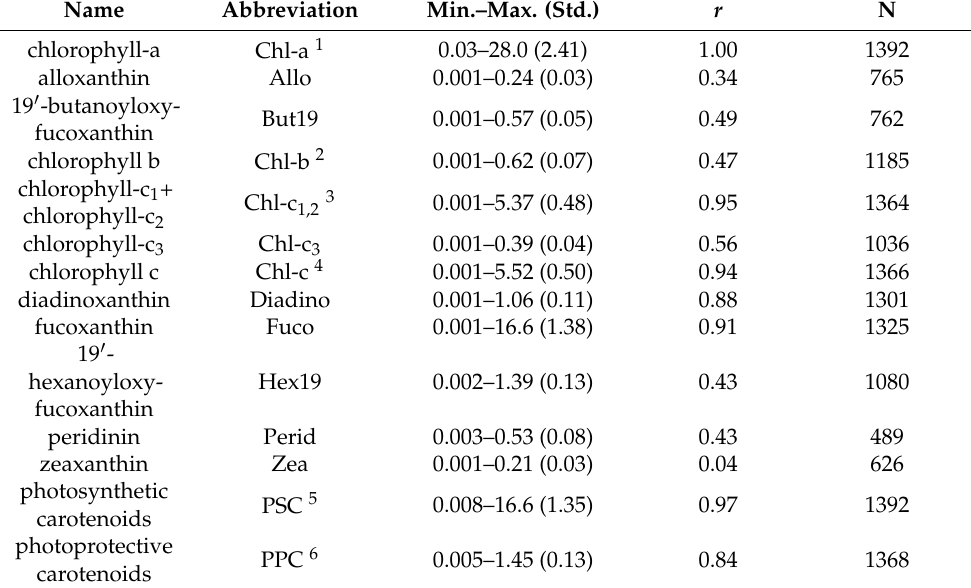
Table 1. Name, abbreviation, and statistical distribution of pigments used in this study.